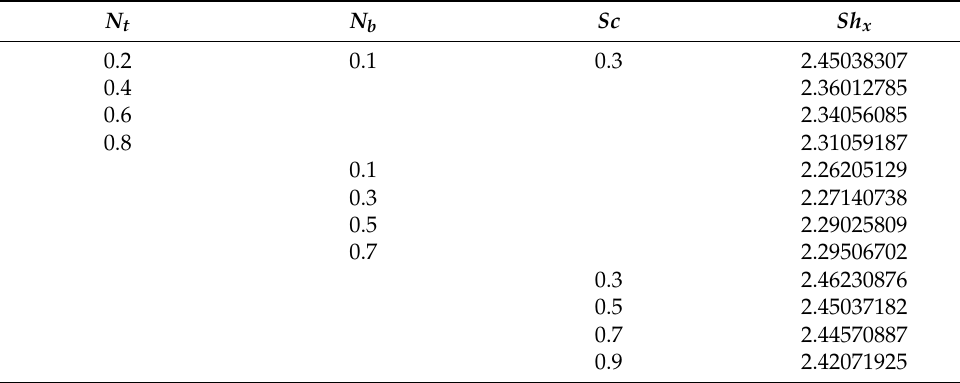
Table 1. Numerical outcomes of Sh x for N t , N b and Sc